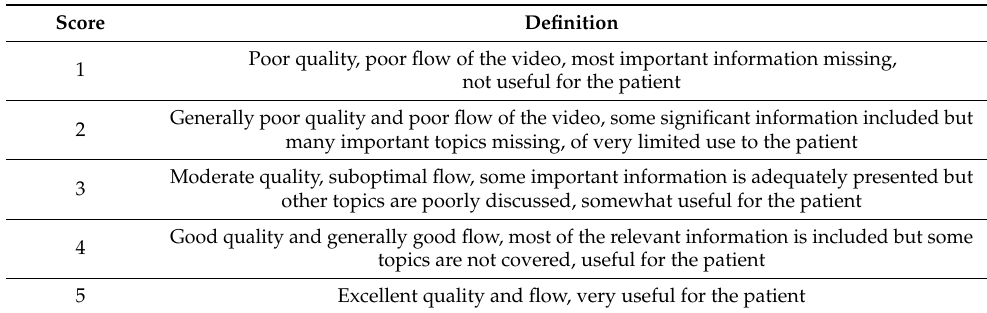
Table 3. The Global Quality Scale